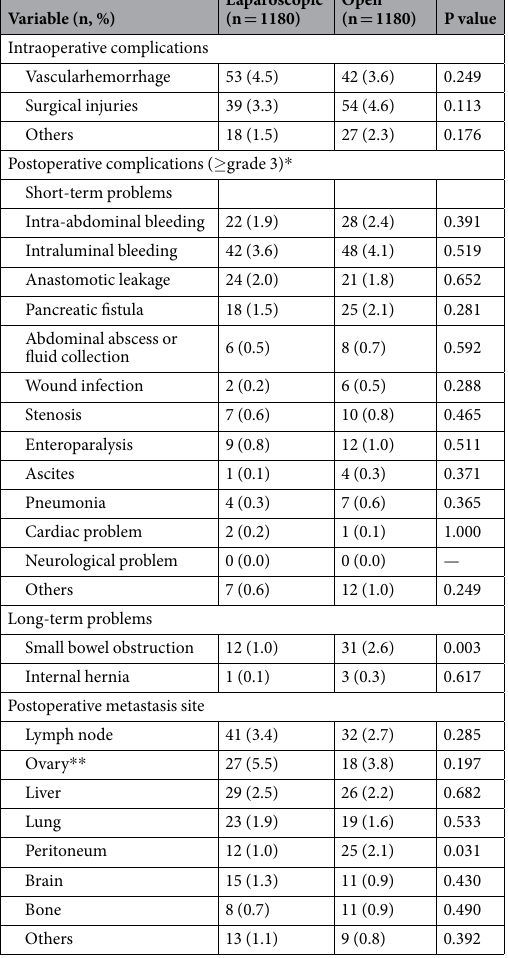
Table 3. Results of complications and metastasis. * According to the Clavien-Dindo classification. ** Calculated and compared only in female